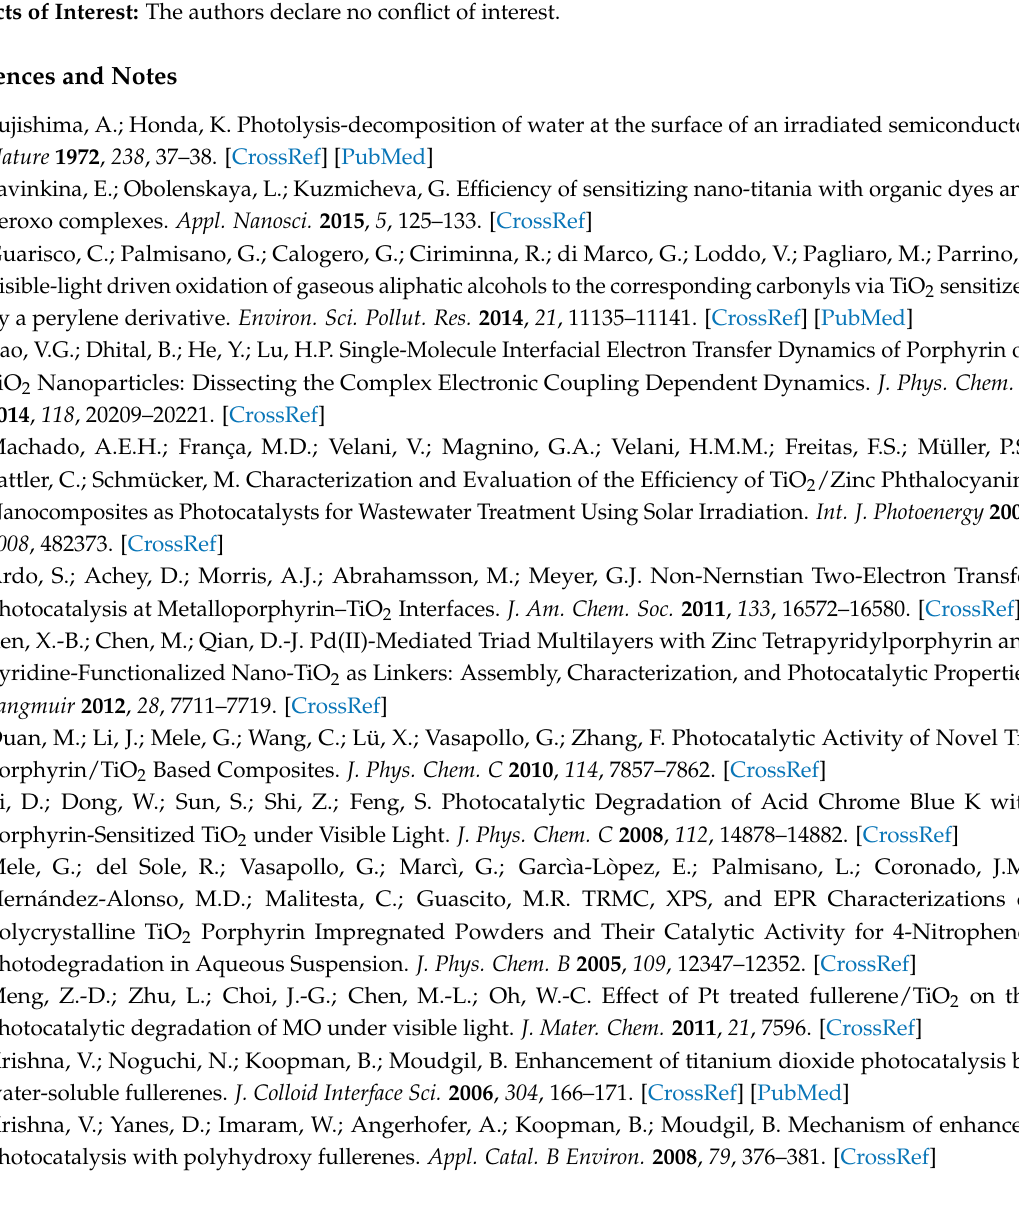
Table S2: List of identified compounds obtained in the photocatalytic degradation of